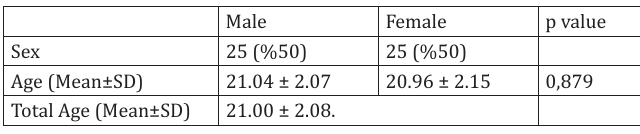
Comparison of sex and ages